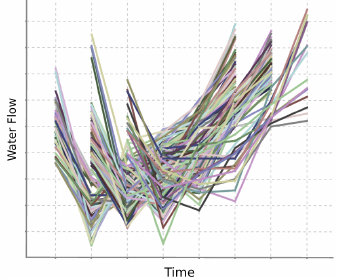
Figure 5. A bicluster with time-misaligned consumption patterns (time-lagged